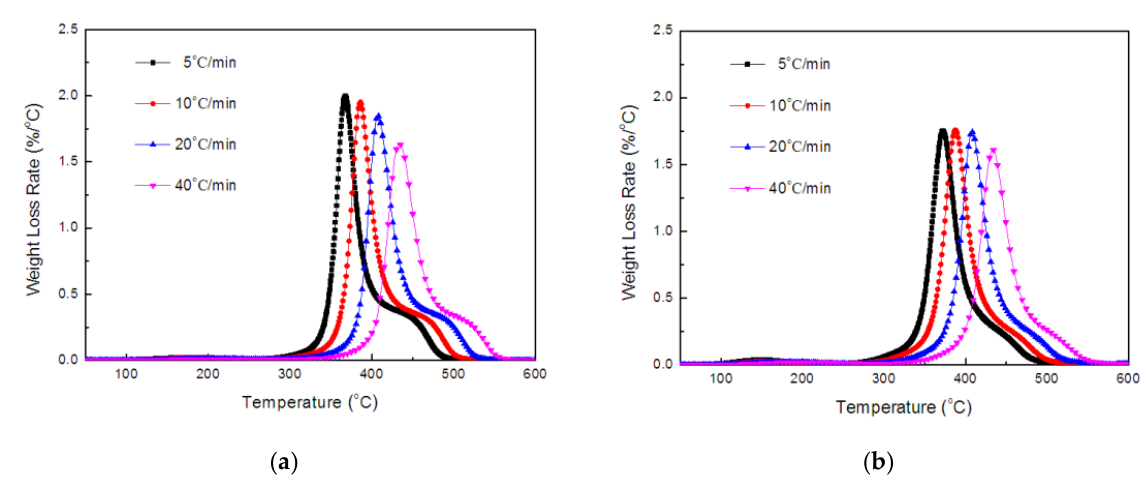
Figure 6. DTG curves of TE ( a ) and FRTE ( b ) composites.